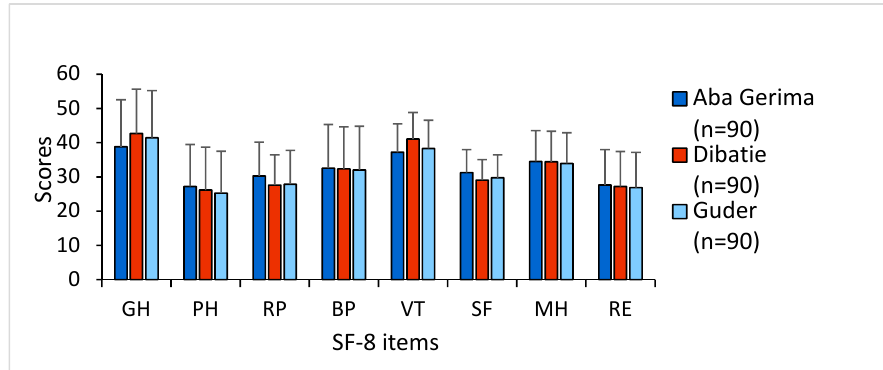
Figure 3. Scores of SF-8 items in different agroecological sites.